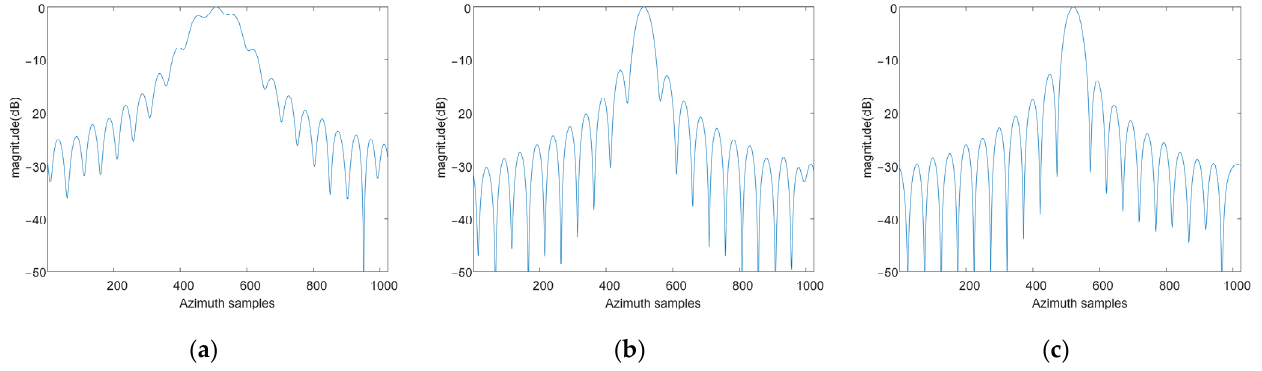
Figure 20. Azimuth profiles of target P5 processed by different algorithms. ( a ) The conventional